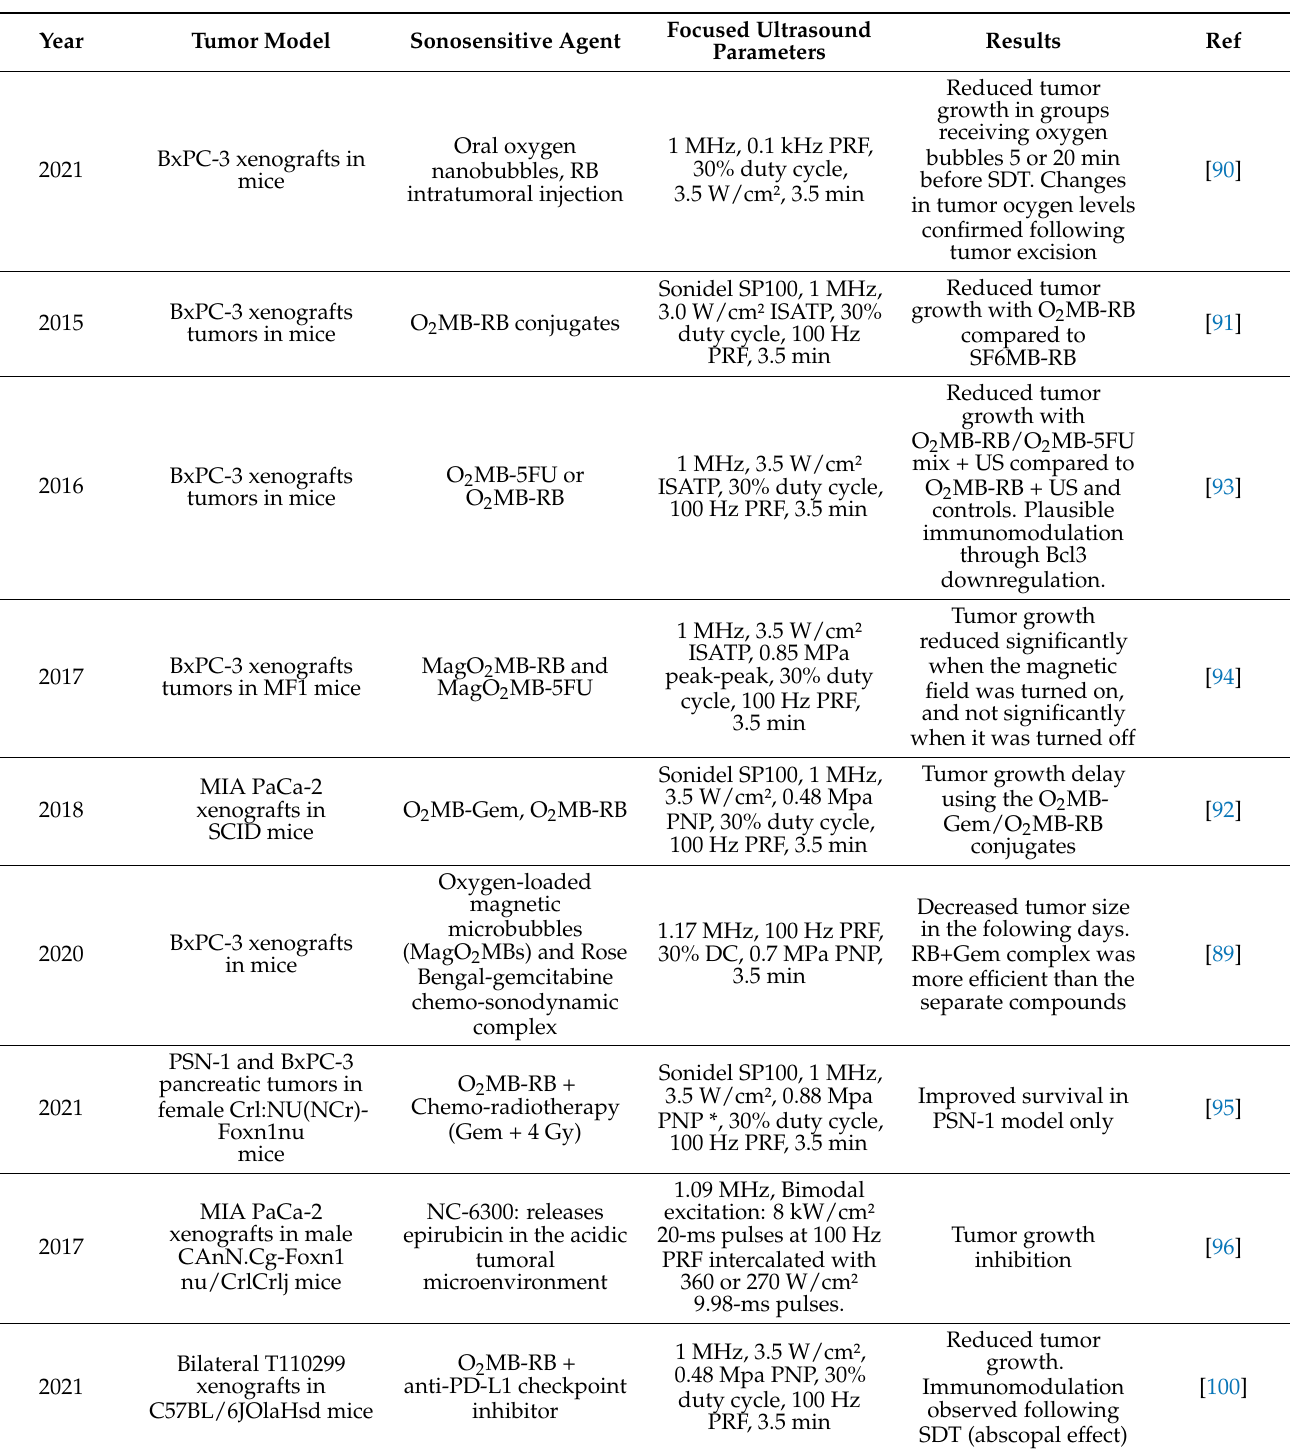
Table 2. Studies on sonodynamic therapy in pancreatic tumor